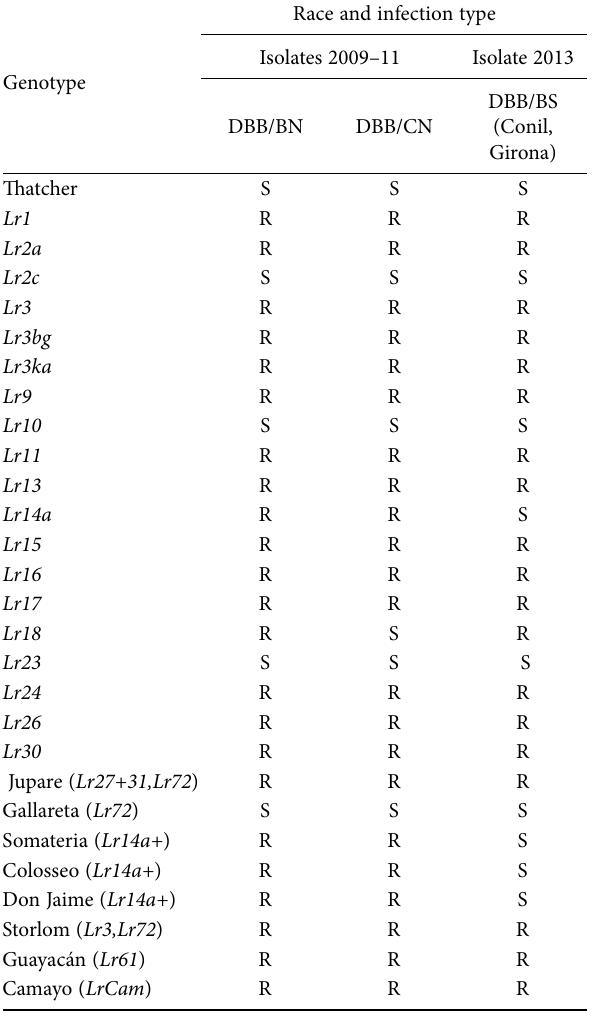
Table 5. Resistance responses of 20 near–isogenic lines and eight durum genotypes, each at the 5 th leaf growth stage, to two races of Puccinia triticina (leaf or brown rust), from 2009–11 and the race of